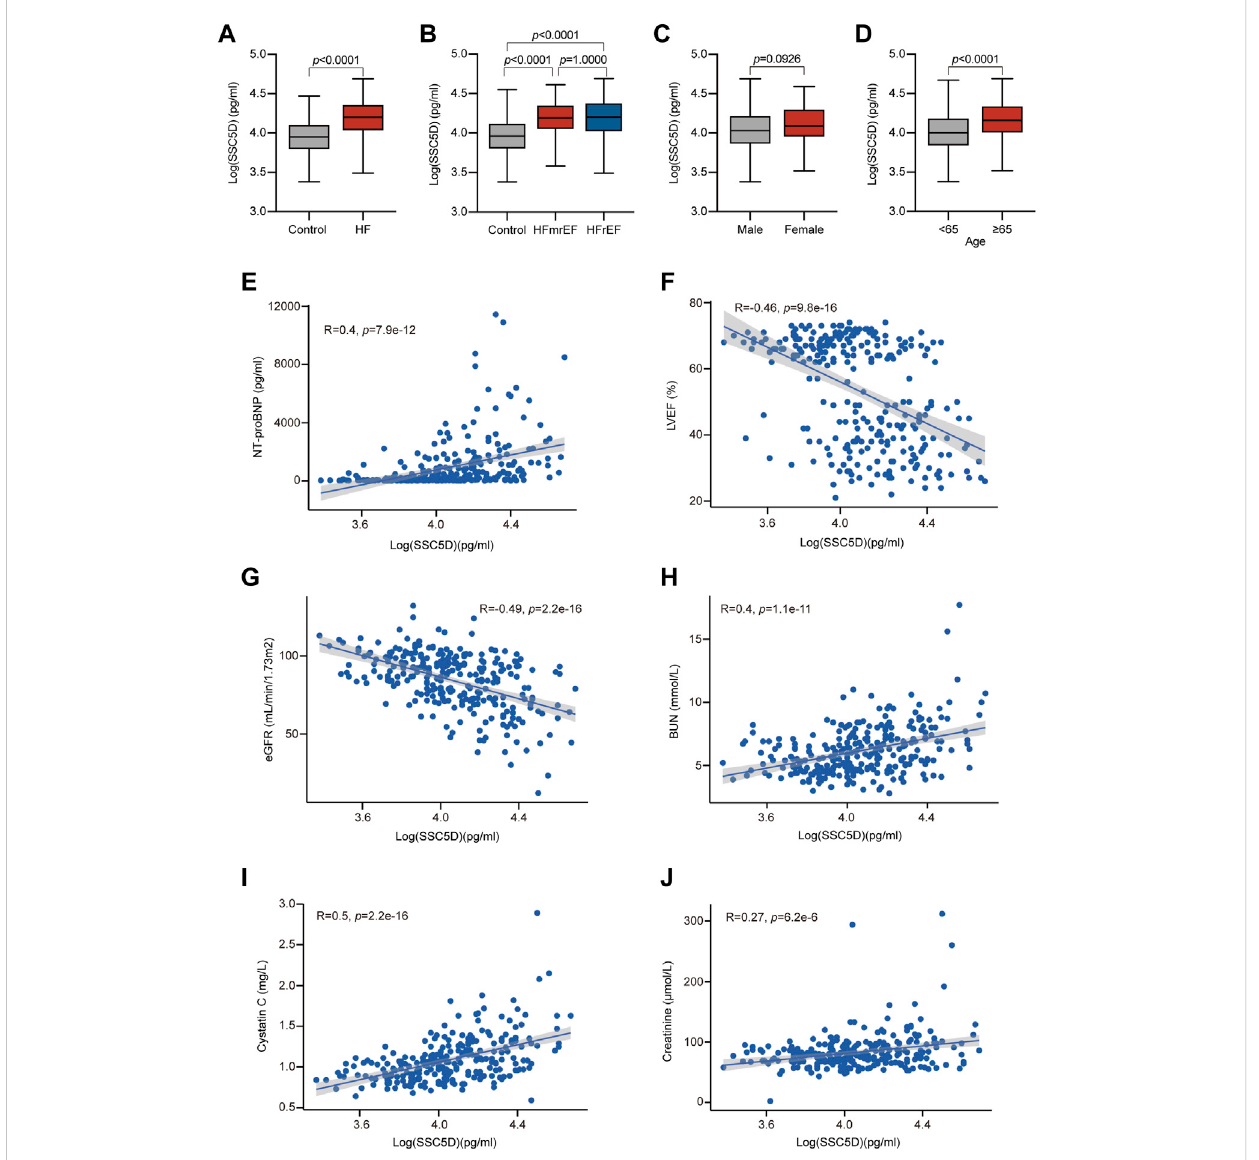
FIGURE 3 Serum SSC5D levels increased in HF patients. (A) Serum SSC5D levels in HF patients compared with control. (B) Serum SSC5D levels in control, HFmrEF, and HFrEF subjects. (C, D) Serum SSC5D levels in male and female, < 65 and ≥ 65 years old subjects, respectively. (E – J) The correlation between serum SSC5D levels and NT-proBNP, LVEF, eGFR, BUN, cystatin c, and creatinine. The SSC5D concentrations were transformed by a logarithm of 10 to obtain normality. p -value < 0.05 was considered statistically signi fi